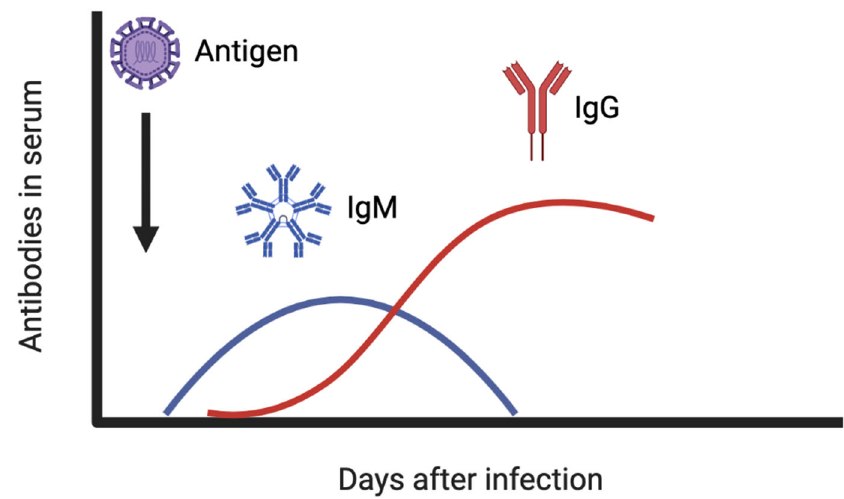
Figure 4. IgM and IgG antibody levels in the serum after viral infection.